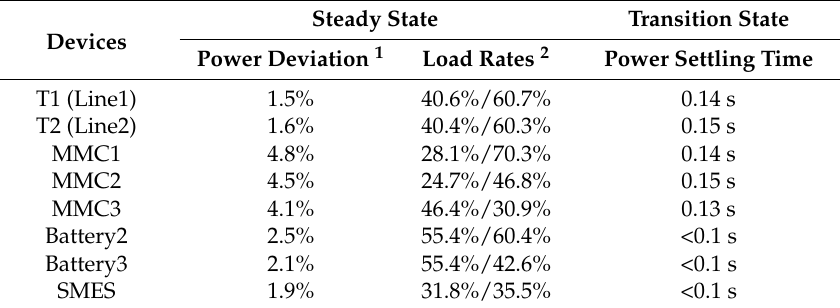
Table 6. Operation indexes during the limited condition of Ba ttery1.